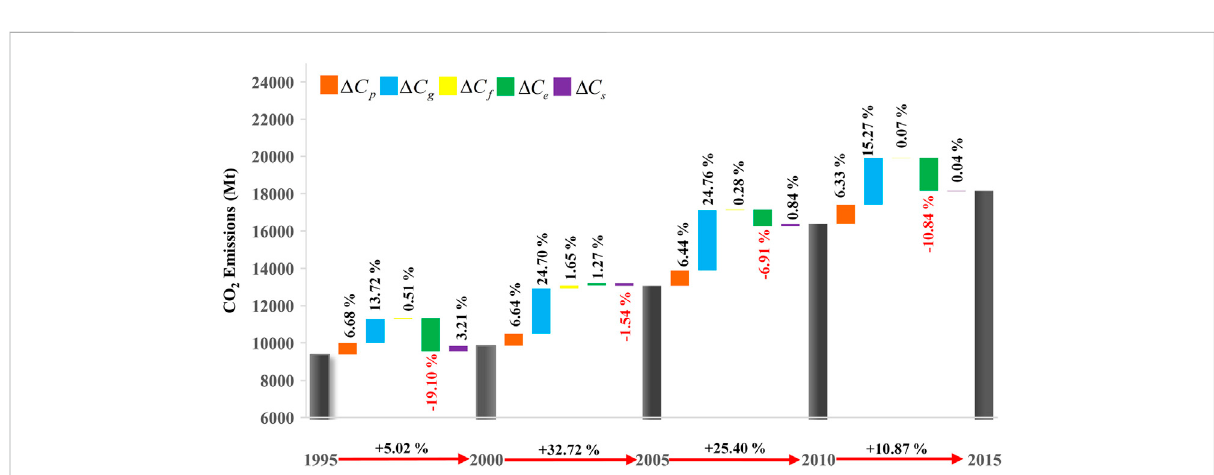
FIGURE 6 Production-based driving factors of carbon emission decoupling in the Belt and Road